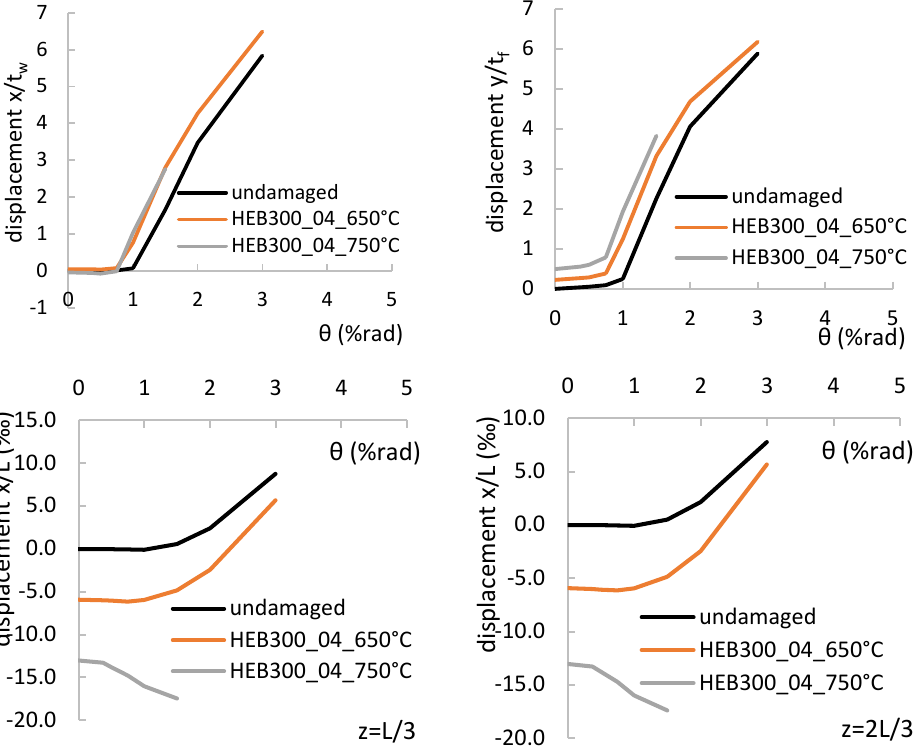
Figure 14. Normalized global out-of-plane displacements for the HEB300_04 columns (first cycle envelope curves). For the loading level P/P y = 0.1, all the columns fail due to the formulation of plastic hinges at the base and their top end, and the local buckling mechanism that triggers global out ‐ of ‐ plane displacements. For higher loading levels, the behaviour depends on the max ‐ imum temperature recorded during the fire stage. For the columns where the flexural strength is less than the full plastic moment of the cross section, although the plastic hinges are not formed, the excessive local buckling deformations trigger the global out ‐ of ‐ plane displacements in the columns again. The residual global out ‐ of ‐ plane displace ‐ ments (post fire displacements) are reverted back to zero and they grow in the opposite direction (Figure 17) very quickly. Thus, the columns fail due to coupled local and global instabilities. Note that when the plastic hinge mechanism is formed, the excessive global out ‐ of ‐ plane displacements are prevented. The only case study where the failure can be attributed to buckling about the weak axis is the heavily damaged column HEA340_04_750 °C. In this case, the plastic hinges were not fully formed, the global out ‐ of ‐ plane displacements grow fast for drift amplitude larger than 0.75%, and the dominant failure is buckling about the weak axis.